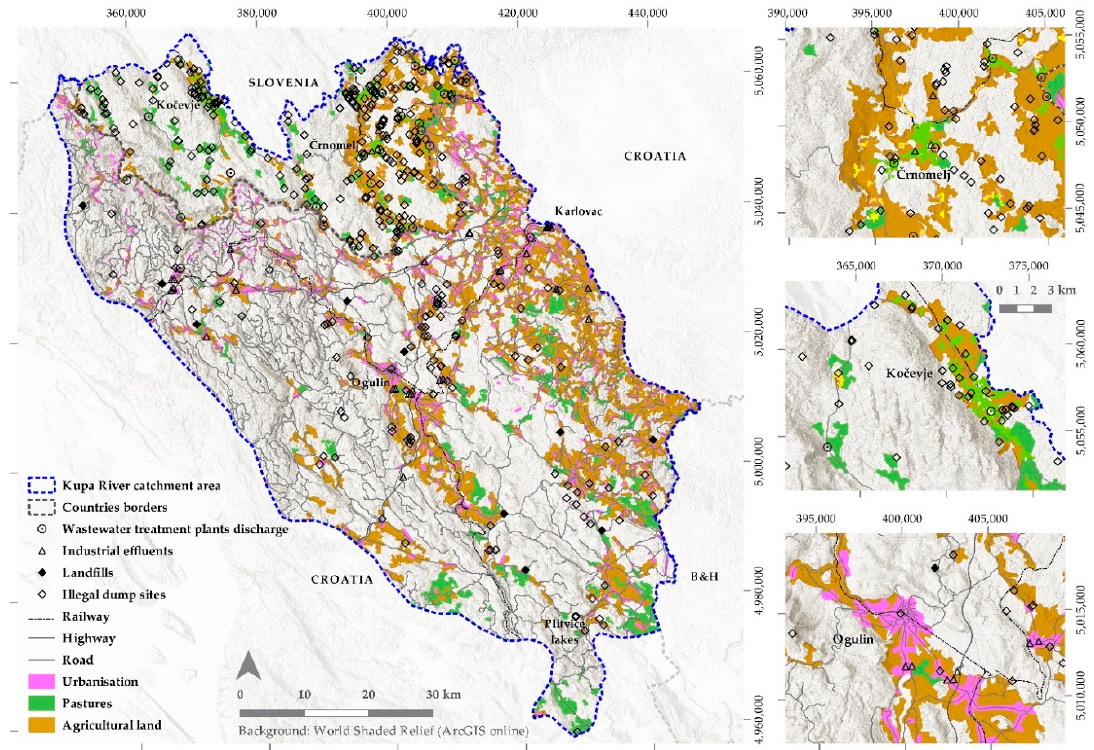
Figure 7. Unclassified hazard map of the Kupa (Kolpa) River catchment area.